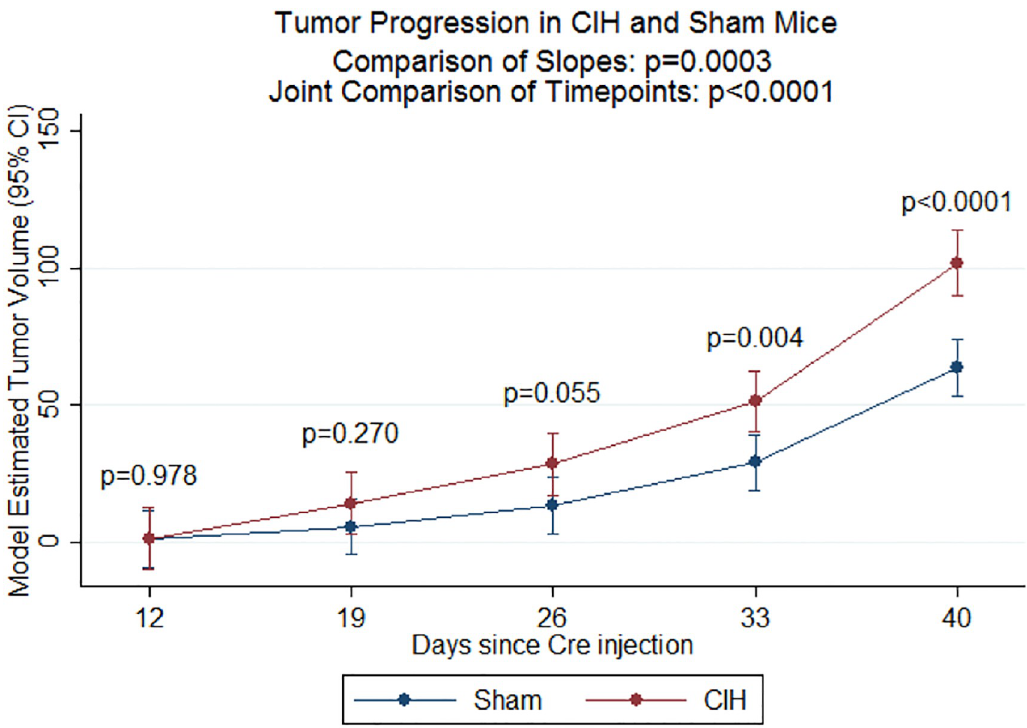
Fig 4. Tumor volume measured by micro CT scans. Tumor volume and associated 95% confidence intervals estimated from linear mixed model analysis are shown. Data for individual mice are shown. We found a significantly faster increase in tumor volume in the CIH versus Sham groups (p = 0.0003) and significant differences between the two groups across all timepoints (overall p < 0.0001). In pairwise comparisons at each individual timepoint, the CIH group had trending or significantly greater tumor volume at day 26 (p = 0.055), day 33 (p = 0.004) and day 40 (p < 0.0001). Sample size is as follows: for CIH at Day 12 (n = 11), Day 19 (n = 11), Day 26 (n = 11), Day 33 (n = 11), Day 40 (n = 10); for Sham at Day 12 (n = 13), Day 19 (n = 13), Day 26 (n = 13), Day 33 (n = 13), Day 40 (n =